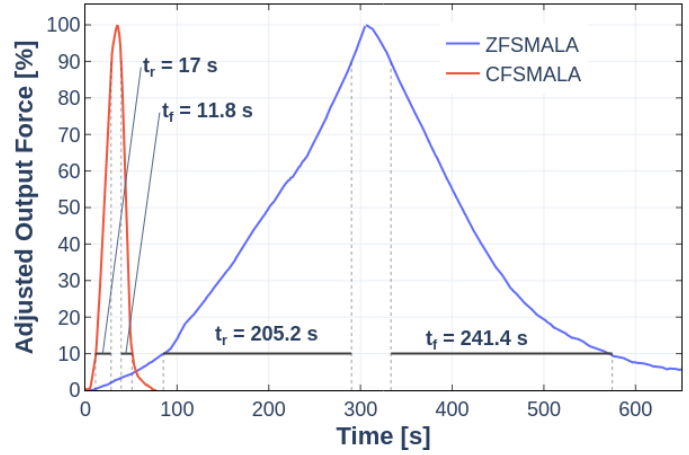
Figure 18. ZFSMALA and CFSMALA force response (Bundle of 10